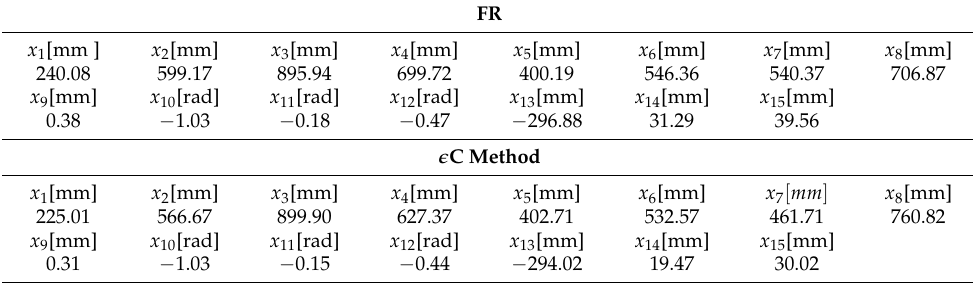
Table A27. Optimum design variables obtained by the best and the worst CHTs for study case 2: Cam-linkage mechanism.